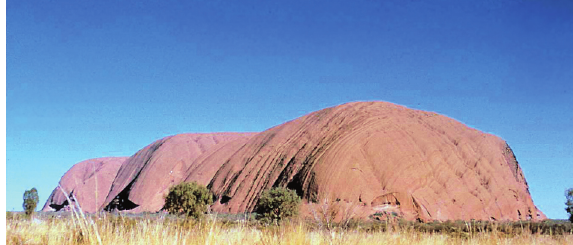
Fig. 1. Ayers Rock (Uluru), Central Australia (Photo C.